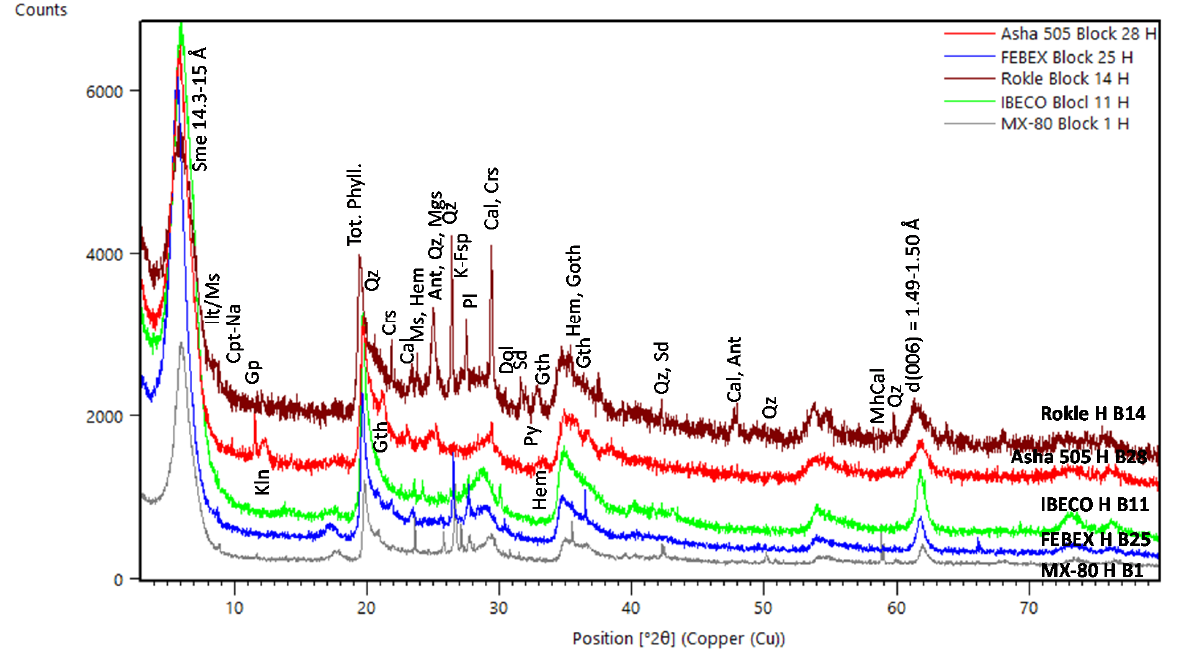
Figure 5. XRD patterns of bulk samples from ABM5 experiment. Symbols according to [43]. Sme: